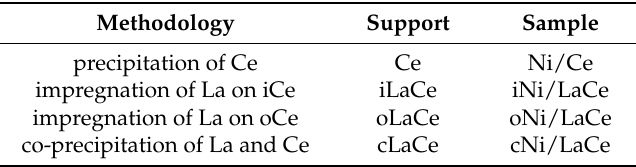
Table 1. Samples’